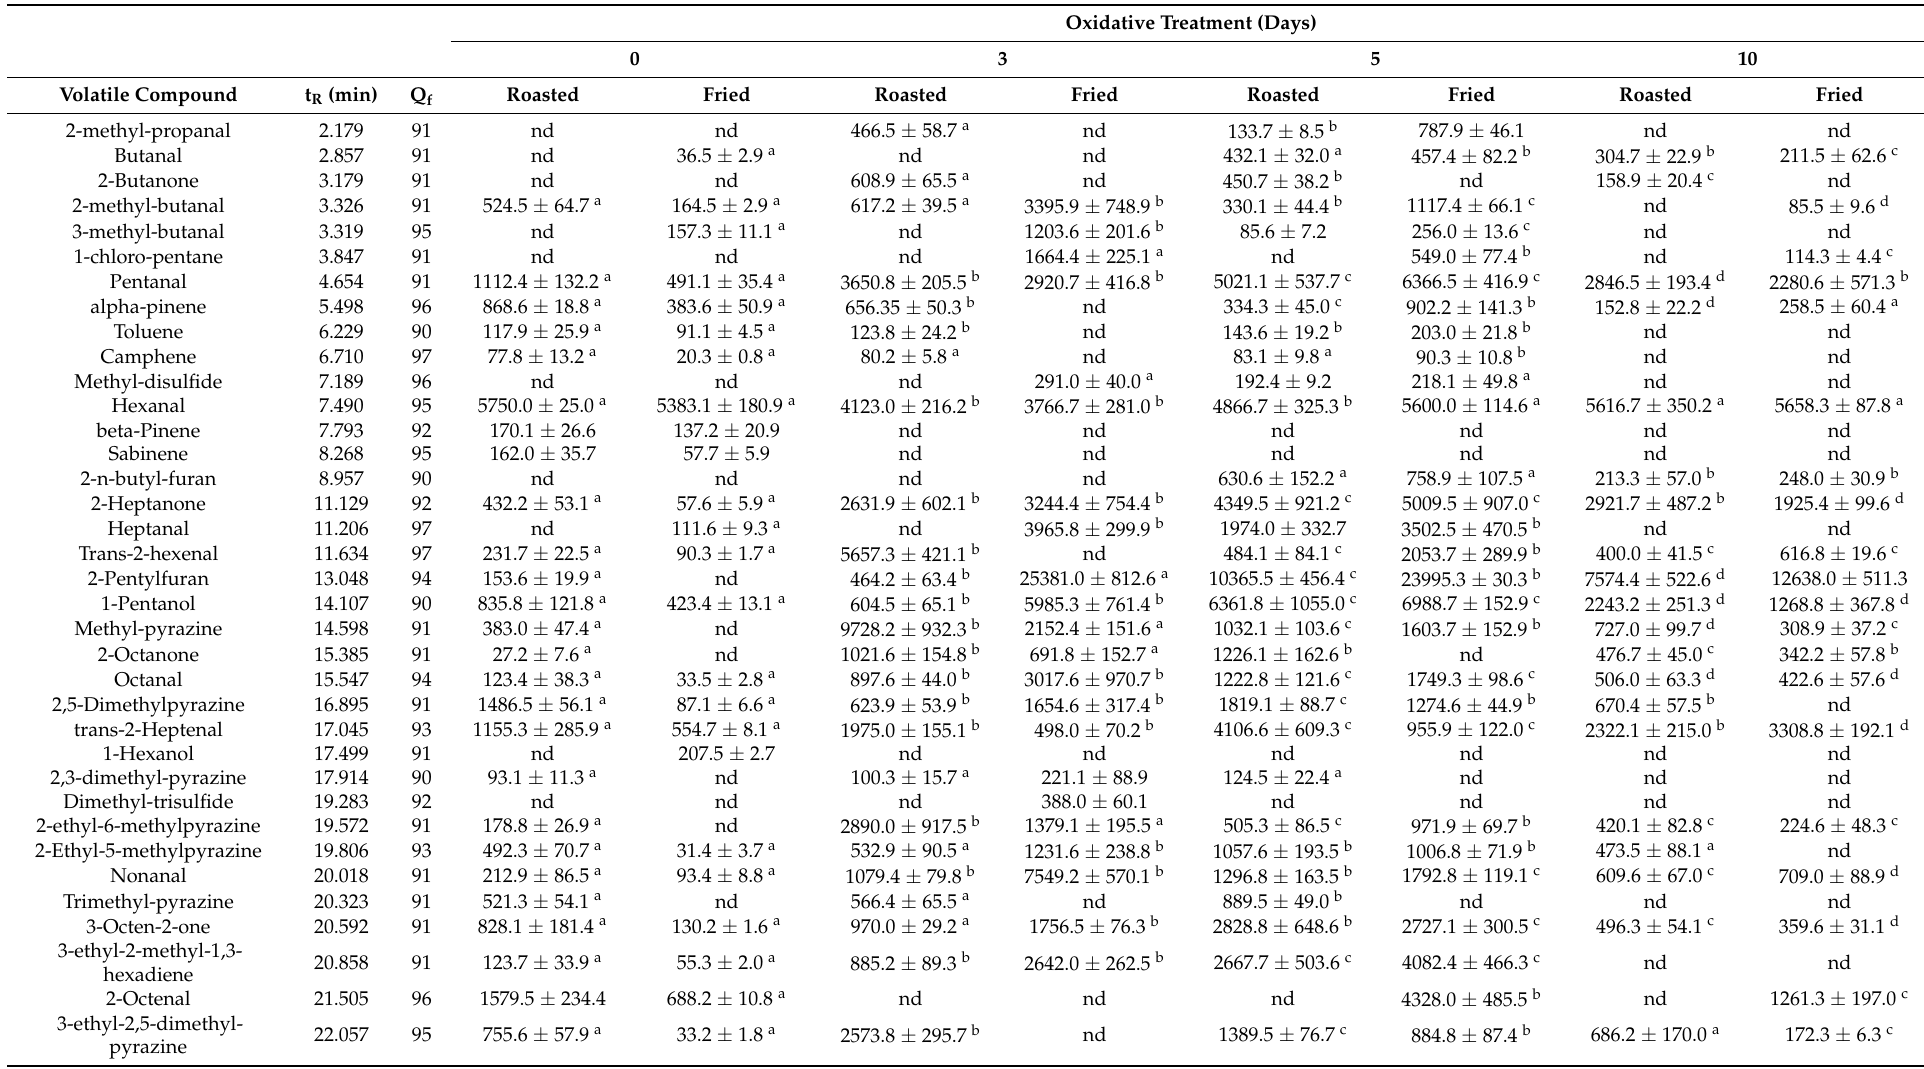
Table 5. Volatile compounds ( µ g · Kg − 1 ) identified in roasted and fried sunflower seeds under accelerated oxidative treatment at 100 ◦ C (mean ± SD, n =